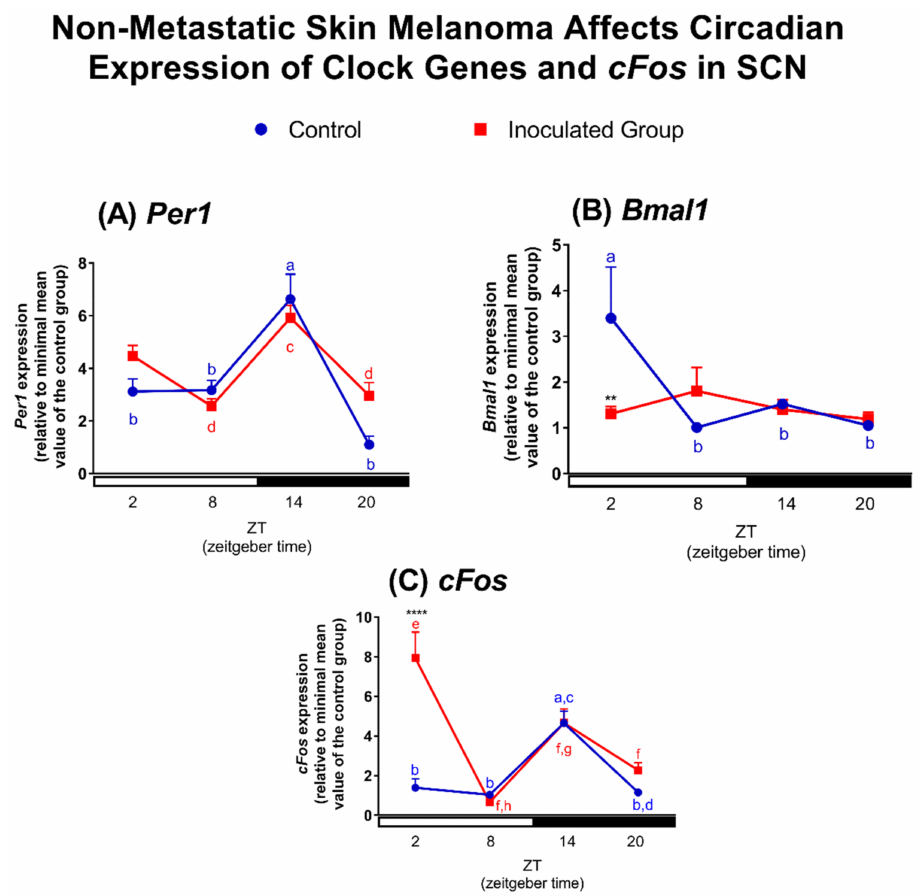
Figure 6. Non-metastatic skin melanoma affects circadian expression of clock genes and cFos in SCN. Expression of ( A ) Per1 , ( B ) Bmal1 and ( C ) cFos in SCN of control and tumor-bearing mice. Letters represent significant differences in gene expression within the same group, Two-Way ANOVA followed by Bonferroni post-test. In ( A ) a (cid:54) = b , p < 0.01 and c (cid:54) = d , p < 0.05. In ( B ) a (cid:54) = b , p < 0.05. In ( C ) a (cid:54) = b and c (cid:54) = d , p < 0.05, e (cid:54) = f , p < 0.01 and g (cid:54) = h , p < 0.001. Significant differences between control and tumor-bearing mice were demonstrated by Two-Way ANOVA followed by Bonferroni post-test, and are represented by asterisks having the control SCN as reference. ** p < 0.01, **** p < 0.0001. Values are presented as the mean expression ( n = 3–7) ± SEM of the gene of interest normalized by Rpl37a RNA, relative to the minimal value found in the control